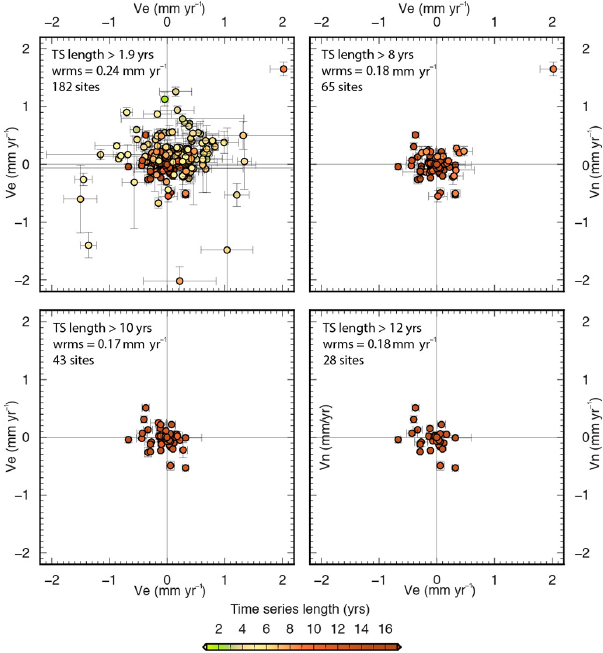
Figure 7. East vs. north components of the residuals relative to a regional reference, color-coded based on the time-series lengths.